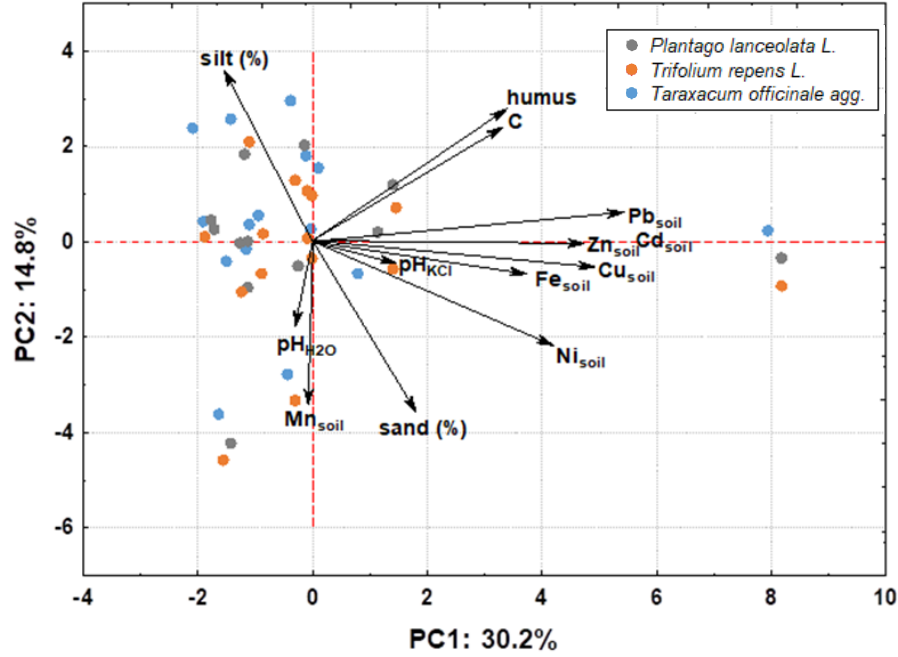
Figure 3. PCA plot showing concentrations of heavy metals in washed plant samples ( Taraxacum officinale , Plantago lanceolata , and Trifolium repens ) in relation to other parameters studied, such as concentrations of heavy metals in soil, texture, soil pH, and organic matter.